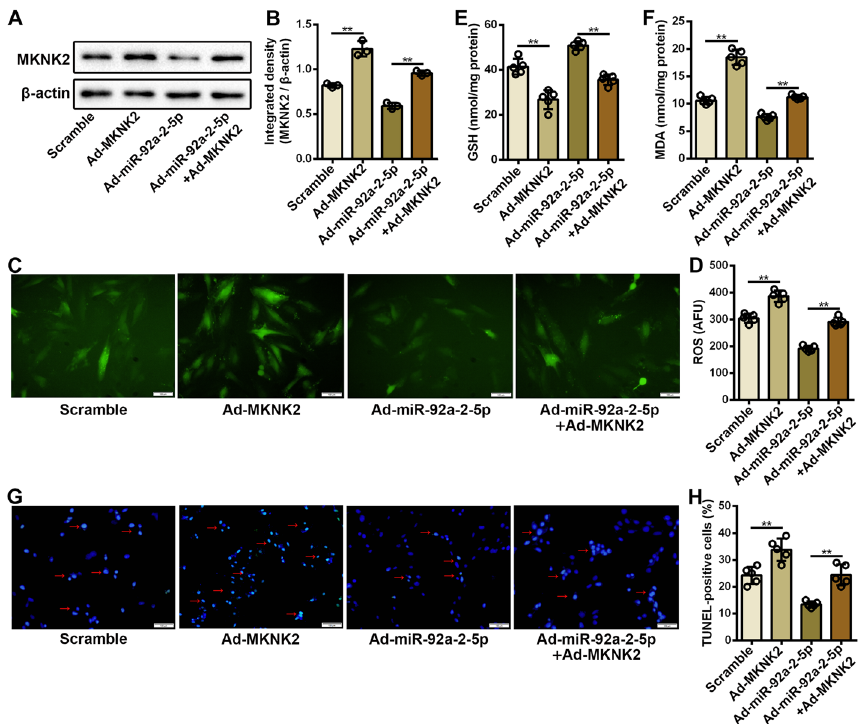
Fig. 5 miR-92a-2-5p attenuated cardiomyocyte oxidative stress injury by targeting MKNK2. A Representative images of western blot for MKNK2 protein in cardiomyocytes infected with Ad-MKNK2 and/ or Ad-miR-92a-2-5p under high glucose stimulation. B Integrated density analysis of immune bands using ImageJ software. β-actin was used as a loading control. n 3 in each group. ** P < 0.01. C Representative = images of DCFH-DA staining in cardiomyocytes with adenovirus infection under high glucose stimulation. D - F Detection of ROS, GSH, and MDA levels in cardiomyocytes infected with adenovirus under high glucose stimulation. n 5 in each group. ** P < 0.01. G Representative images of TUNEL staining of cardiomyocytes = infected with adenovirus under high glucose stimulation. The red arrows indicate the TUNEL-DAPI merge signals. H Detection of TUNEL-positive cardiomyocytes with adenovirus infection under high glucose stimulation. n 5 in each group. ** P < =